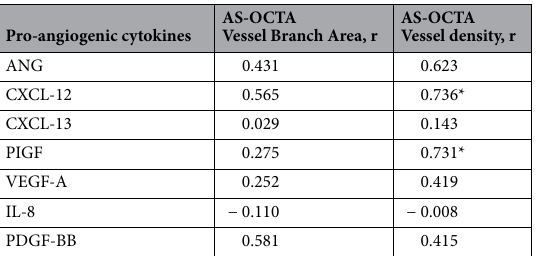
Table 2. Spearman’s (r) correlation matrix of changes in aqueous pro-angiogenic biomarkers in relation to anterior segment optical coherence tomography angiography (AS-OCTA) vessel densities and vessel branch area. *p < 0.05 level